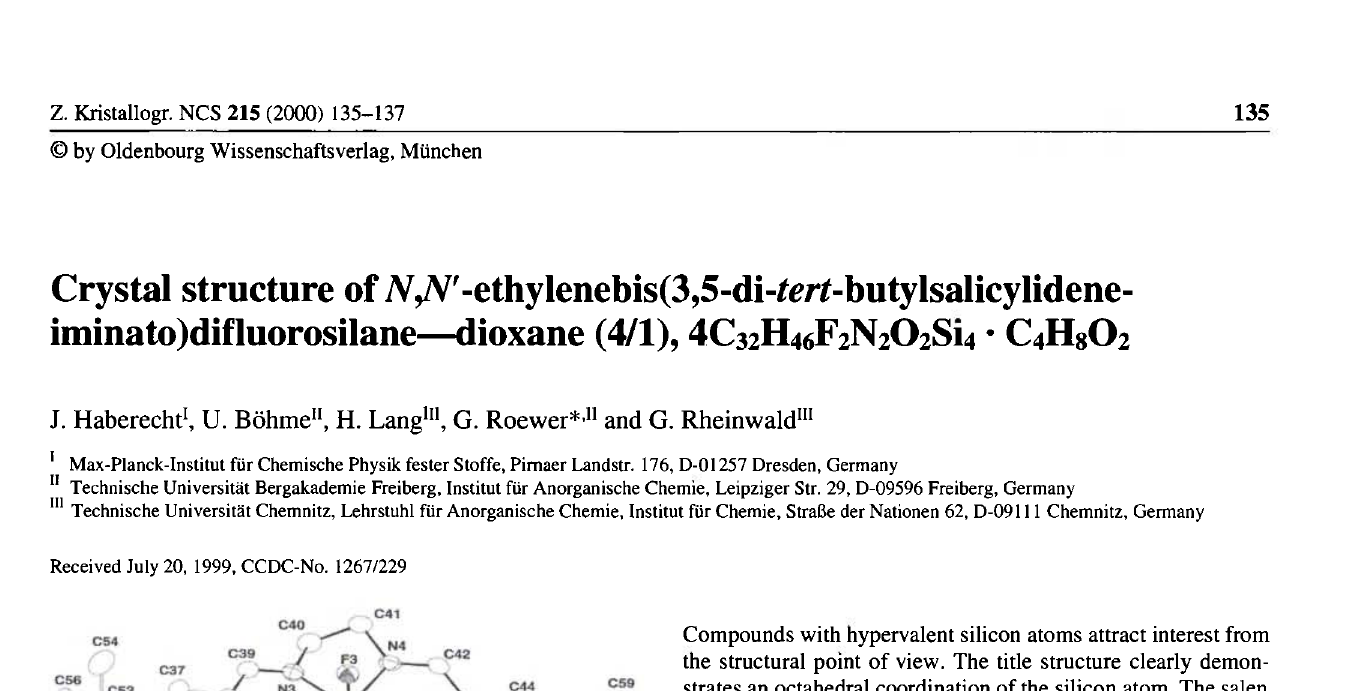
C60 Table 2. Atomic coordinates and displacement parameters (in Ä 2